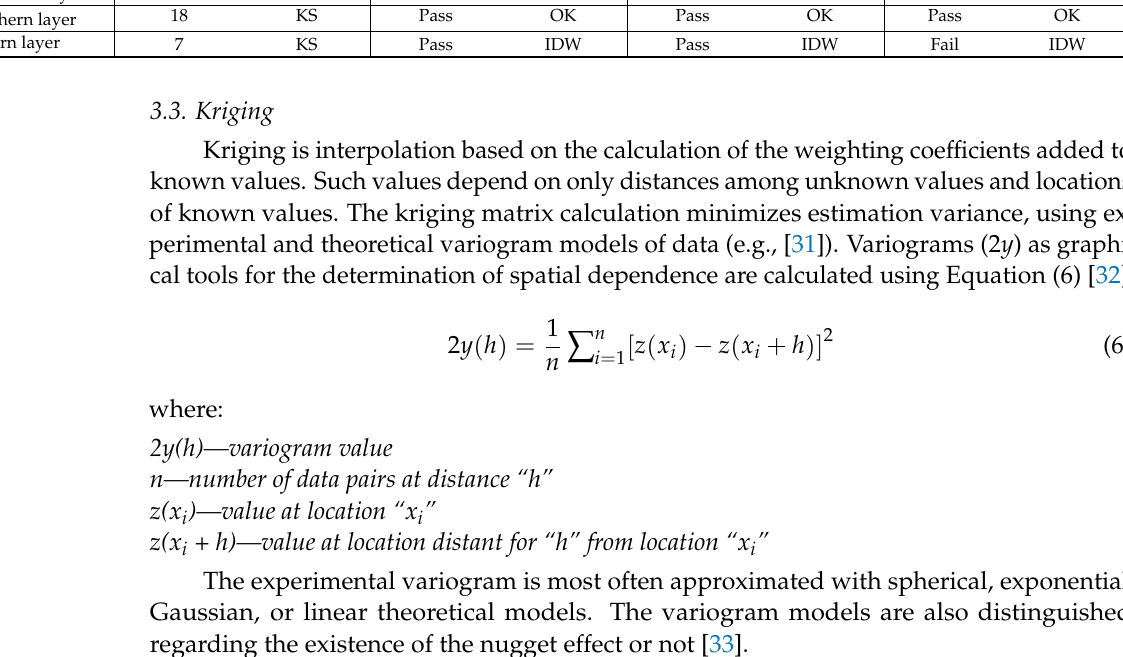
Interpolation Method